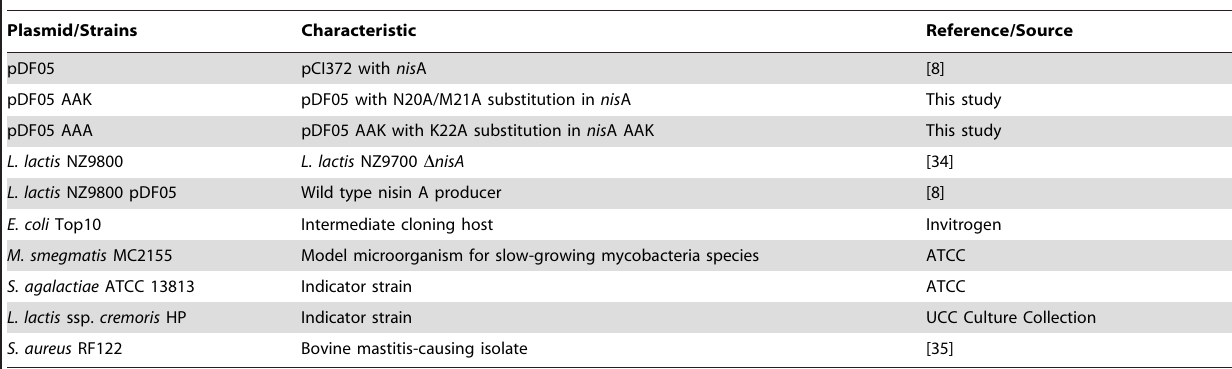
Table 1. Plasmids & strains used in used in this study.